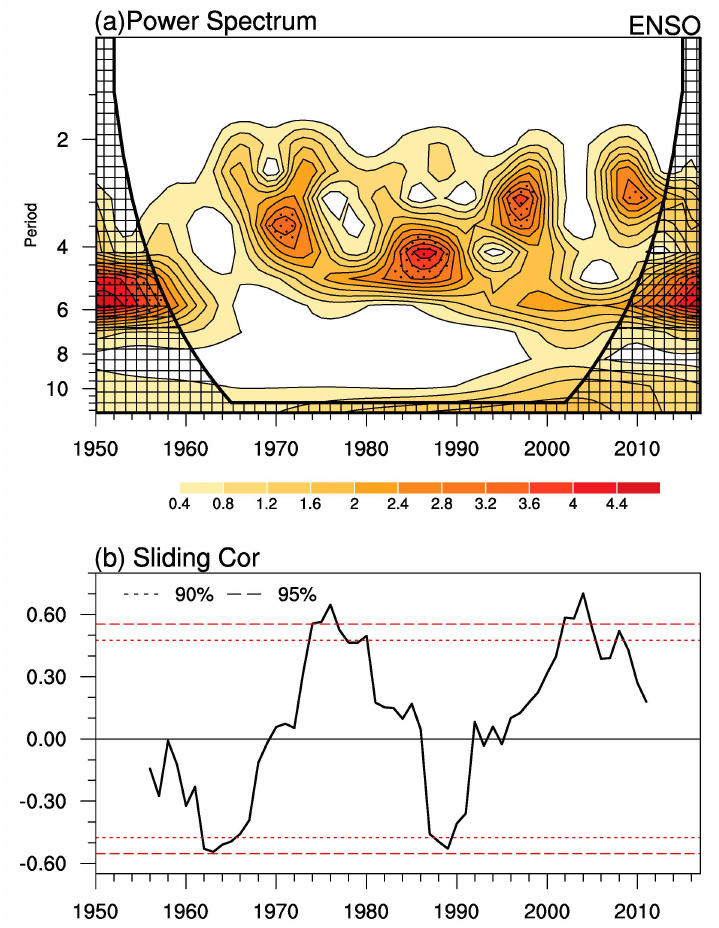
Figure 3. ( a ) Wavelet power spectrum of the Niño-3.4 index. The regions exceeding the 95% confidence level against red noise are dotted. ( b ) 13-year running correlation coefficients between the NWPSH index (defined as the JJA(1) averaged geopotential height anomalies over the region of 10 ◦ –27.5 ◦ N and 100 ◦ –160 ◦ E (black box highlights the region over the Northwest pacific NWP in Figure 3)) and the North Pacific high (NPH) index (defined as the JJA(1) averaged geopotential height anomalies over the region of 32.5 ◦ –50 ◦ N and 120 ◦ E–150 ◦ W (black box highlights the region over the mid-latitude North Pacific in Figure